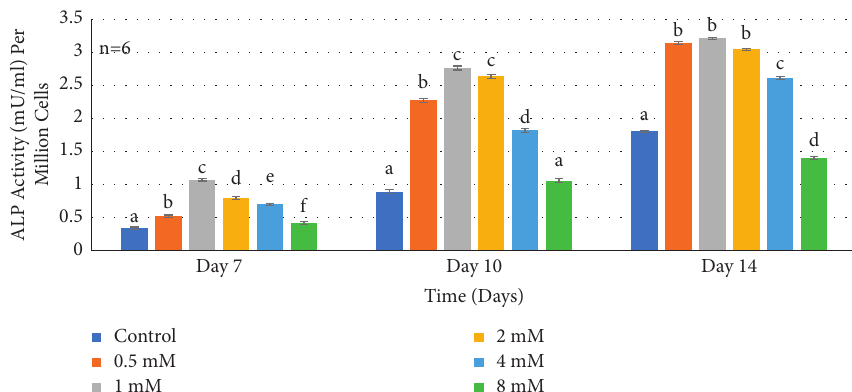
Figure 4: Histogram showing alkaline phosphatase activity of normal human dental pulp cells in media with supplemental Mg 2+ con- centrations. Note: normal human dental pulp cells were cultured with media containing supplemental magnesium concentrations 0.5mM, 1mM, 2mM, 4mM, and 8mM and 0mM as the control group for time periods of 7, 10, and 14 days. Alkaline phosphatase activity in supernatants was normalized per million cells at each time interval. The control cells were treated with growth media without supplemental Mg 2+ . The data are presented as means of six replicates with error bars indicating the standard deviation. Groups labeled with different letters differ statistically as compared to the control group and other study groups ( P < 0 .